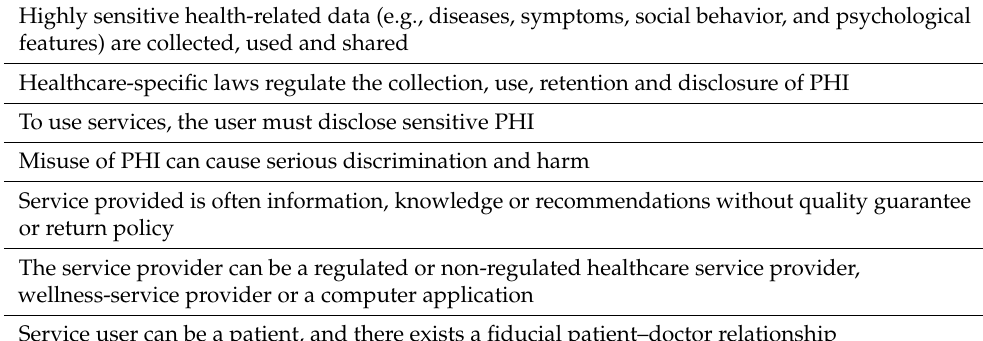
Table 1. Specific features of eHealth ecosystems.